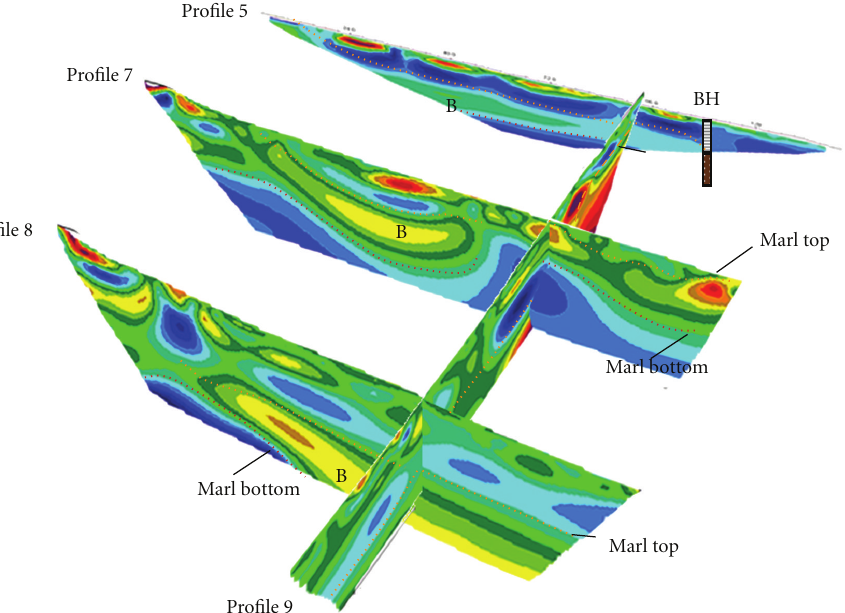
Figure 9: Perspective map of ERT profiles located in sloping area. Profile location in Figure 5(c).